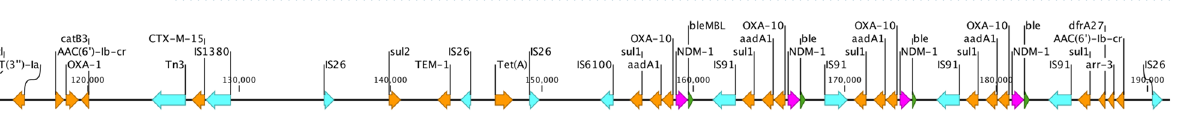
Figure 4. Analysis of IncX3 plasmid sequences harboring bla NDM-5 in this study.